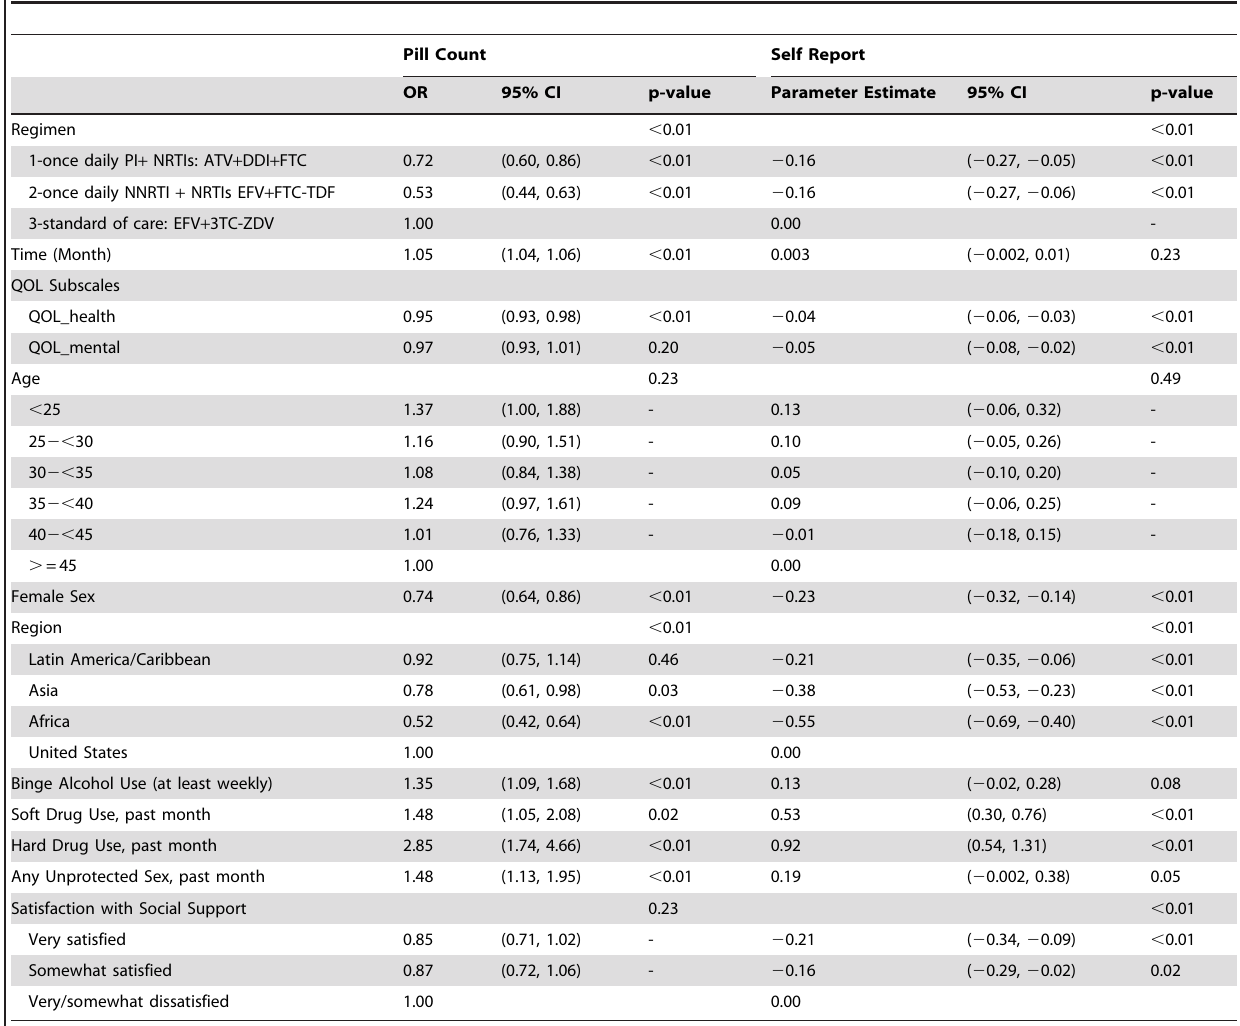
Table 2. Longitudinal Bivariate Predictors of Non-Adherence (Missed any pills since last visit) 1,2 .